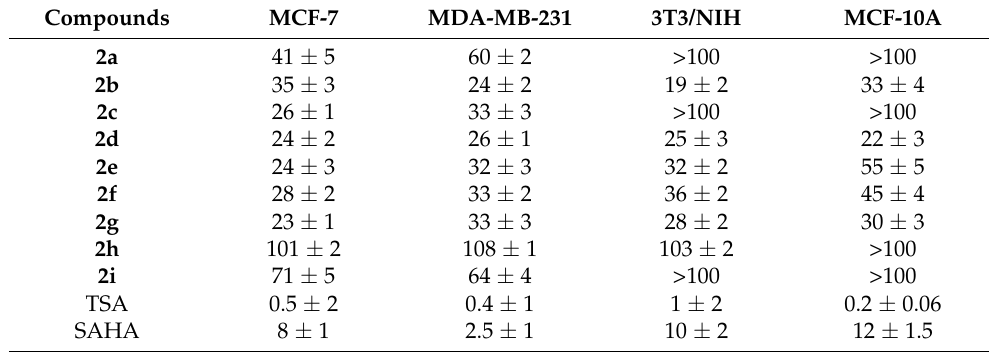
Table 2. Cytotoxic activity of 2a – i and reference compounds (IC 50 µ M) on several cell lines.